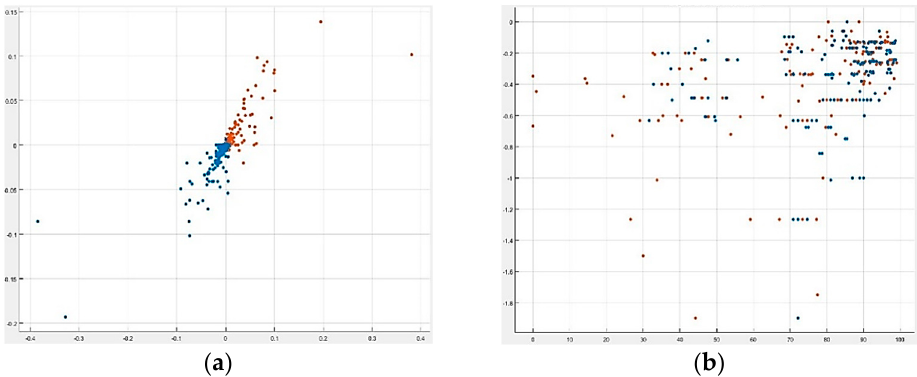
Figure 3. An instance of skin conductance predictors and skin temperature. The orange color indicates the stress class and blue the nonstress class: ( a ) skin conductance predictors separate classes well; ( b ) temperature predictors did not separate the classes well. Table 1. Performance for each signal (skin conductance: SC, skin temperature: ST) per classifier. The F1-score is also an important metric when there are imbalanced classes as in our case.